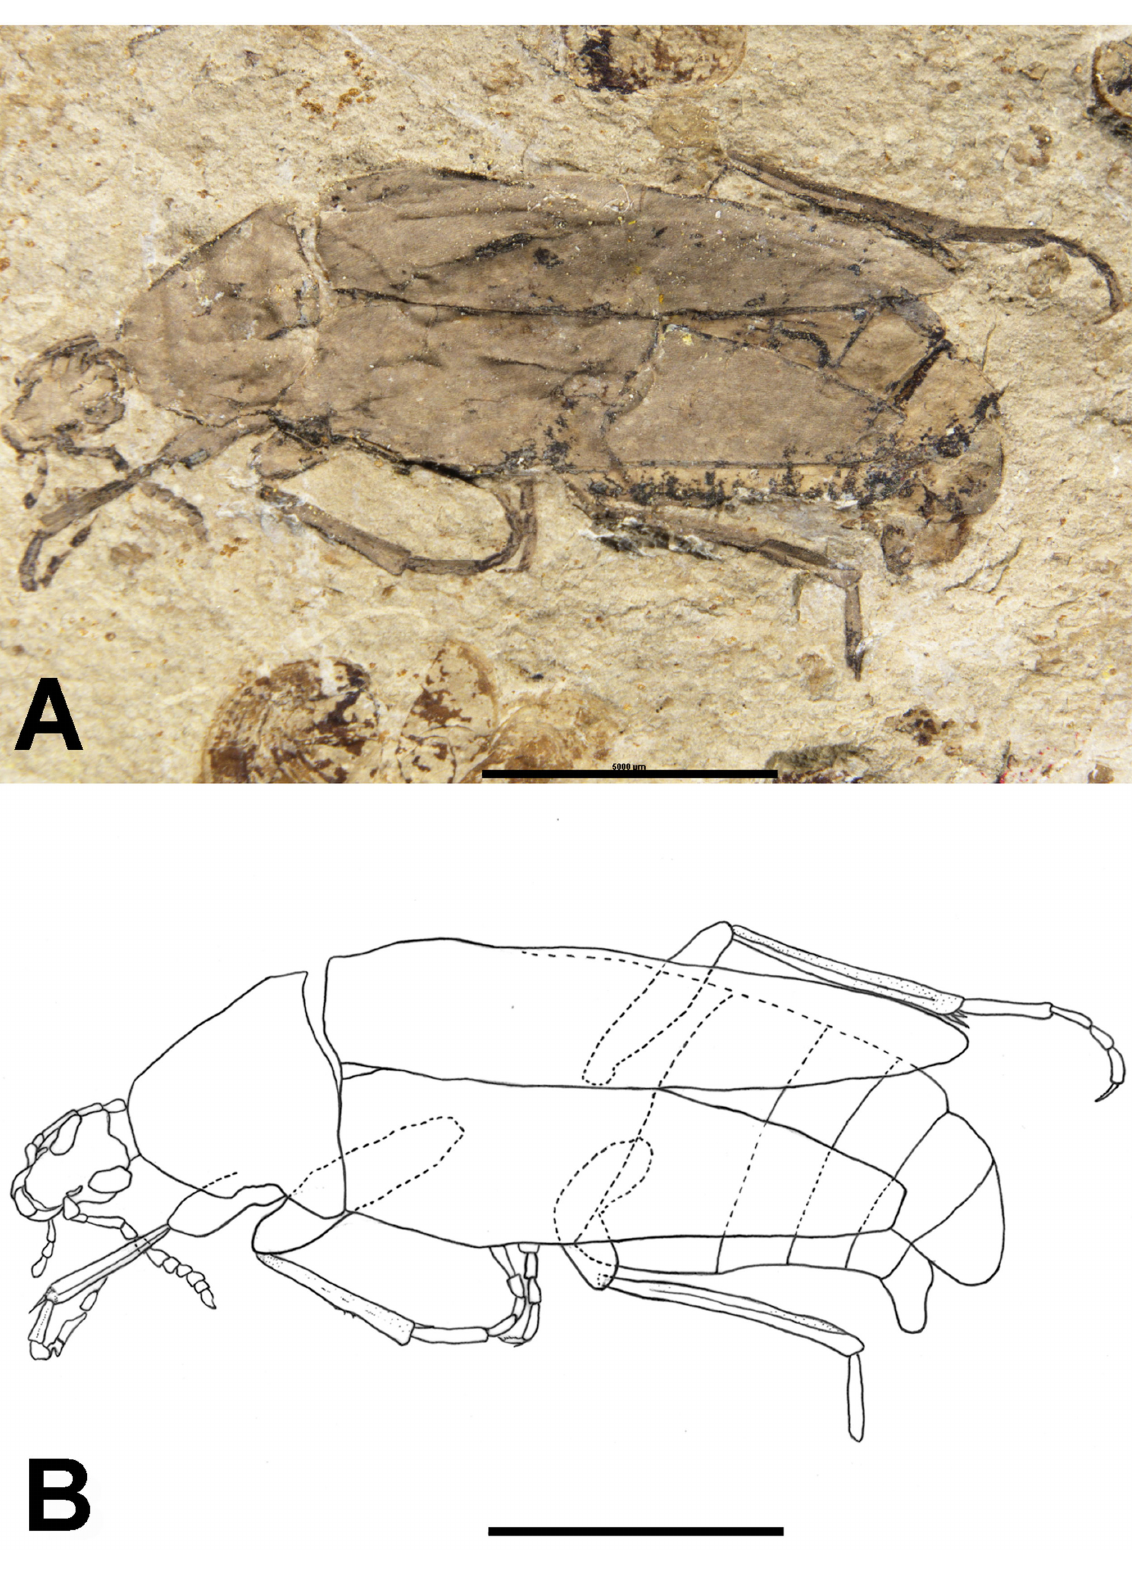
Fig. 2. Archaeoripiphorus nuwa Hsiao, Yu & Deng gen. et sp. nov., holotype. A . Photograph of complete specimen. B . Habitus drawing. Scale bars =